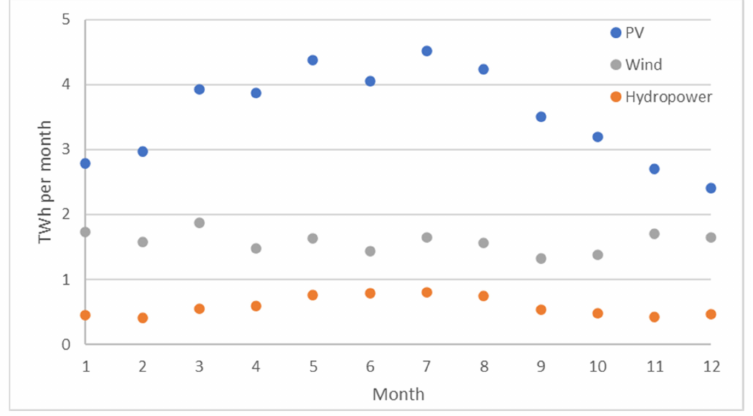
Figure 13. Incremental electricity generation in 2050 compared with 2019 over the course of the year for EDS.